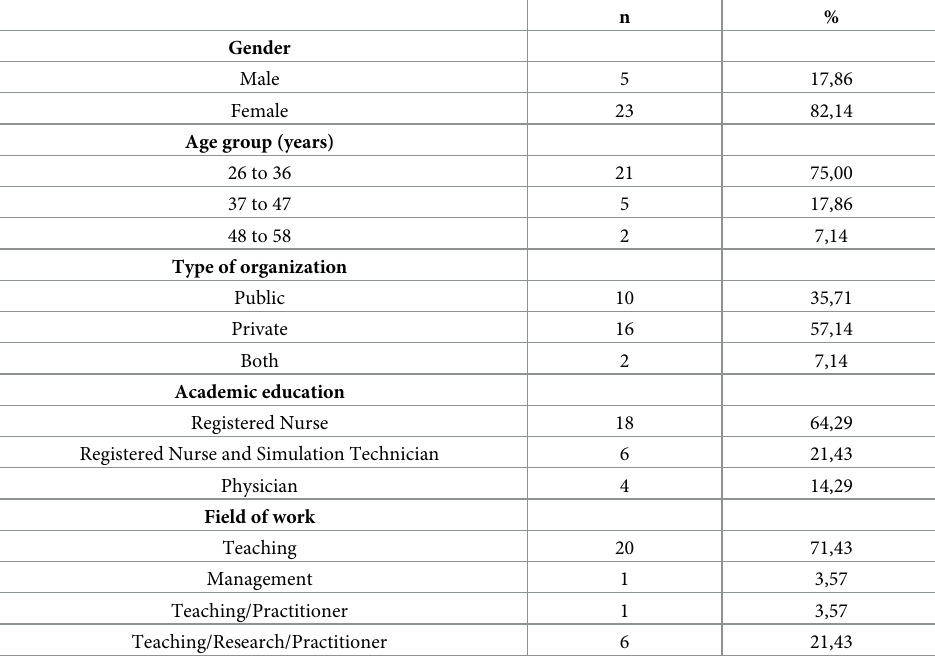
Table 4. Demographic of health professionals—test (n = 28). S ã o Paulo,